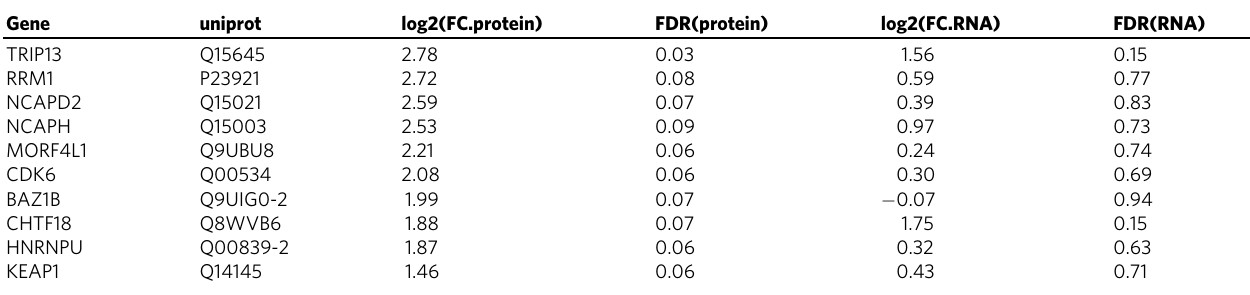
Table 1 Top upregulated proteins detected in global proteomics with their RNAseq pro fi le. Gene uniprot log2(FC.protein) FDR(protein)